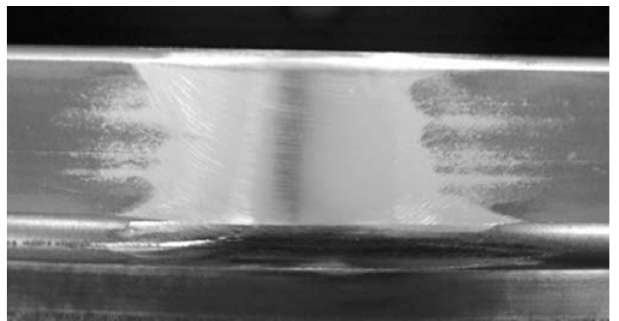
Figure 2. Weld after grinding [23].